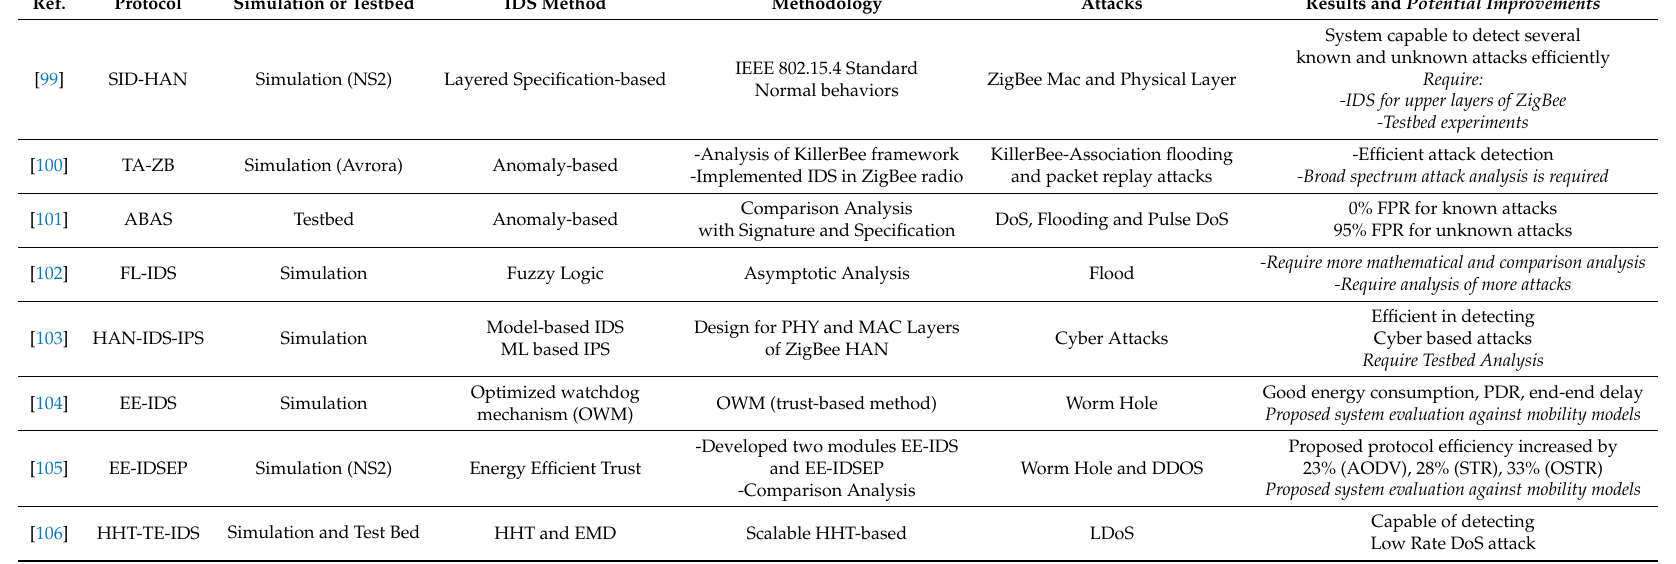
Table 4. Summary of ZigBee-based